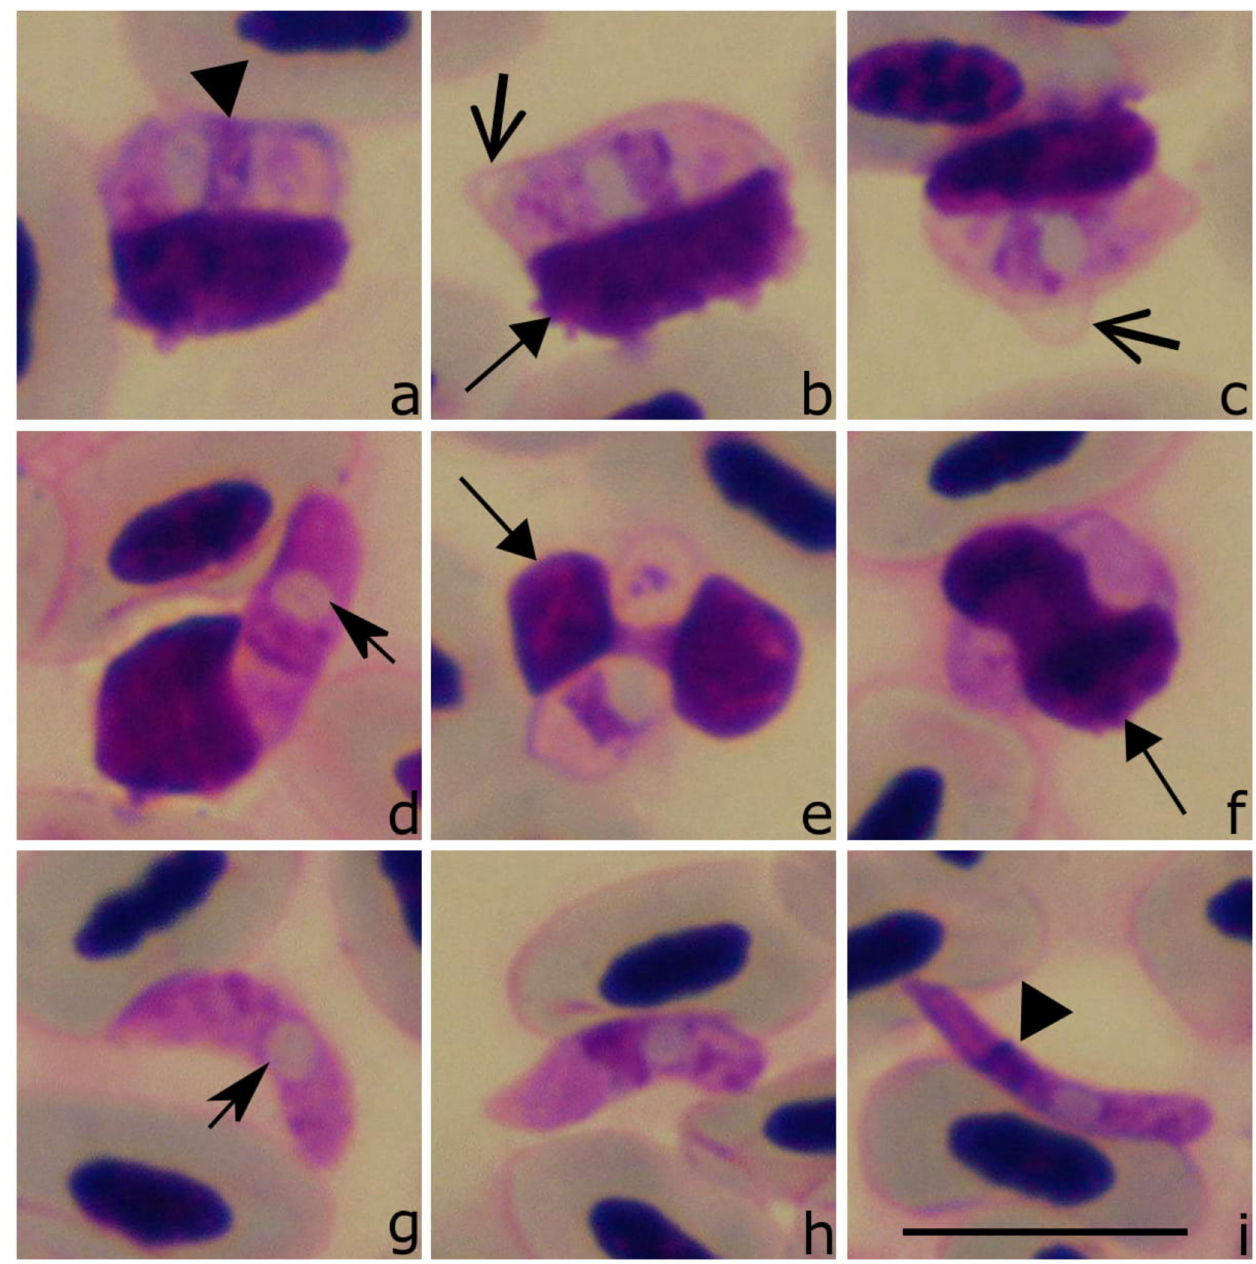
Figure 6. In vitro sporozoites ( a – i ) of Lankesterella kabeeni 18S rRNA lineage LanAcro8 isolated from the sedge warbler Acrocephalus schoenobaenus . Sporozoite in a circulating thrombocyte before exposure blood to air (EBA) ( a ). Note that the sporozoites deform the host cell envelope 1 min after EBA ( b , c ), when they start to escape from host cells ( d ). Within 3 min after EBA, the deformation of infected host cells is readily visible during this process ( e , f ). Free (extracellular) sporozoites were frequently seen 1h after EBA ( g – i ). Triangle, parasite nucleus. Short, barbed arrow, vacuole-like structure. Short triangle arrow, host cell nucleus. Simple wide arrow, host cell envelope. Scale bar: 10 µ m. Methanol fixed and Giemsa-stained blood